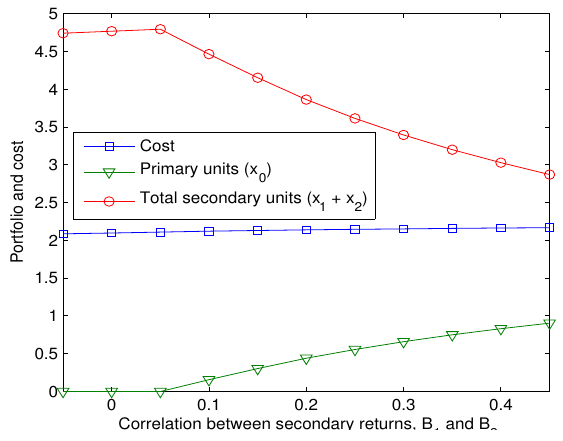
Figure 9. Correlation between secondary